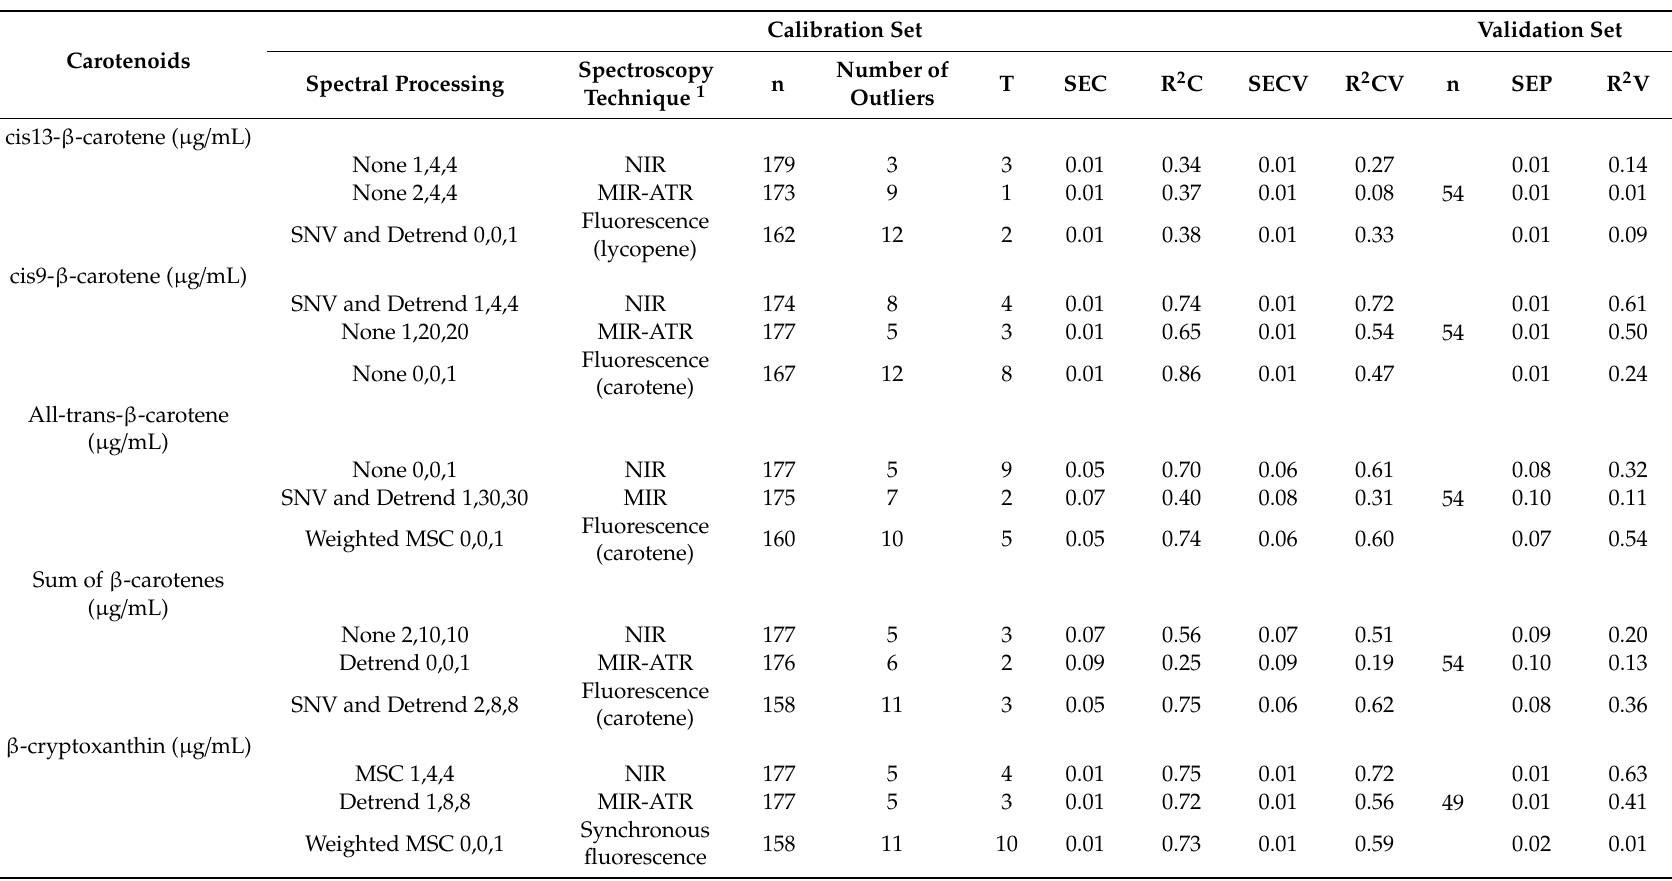
Table 3. Prediction of di ff erent carotenoids in cow milk according to the equations developed from three spectroscopy techniques: near-, mid-infrared (NIR and MIR, respectively) and fluorescence